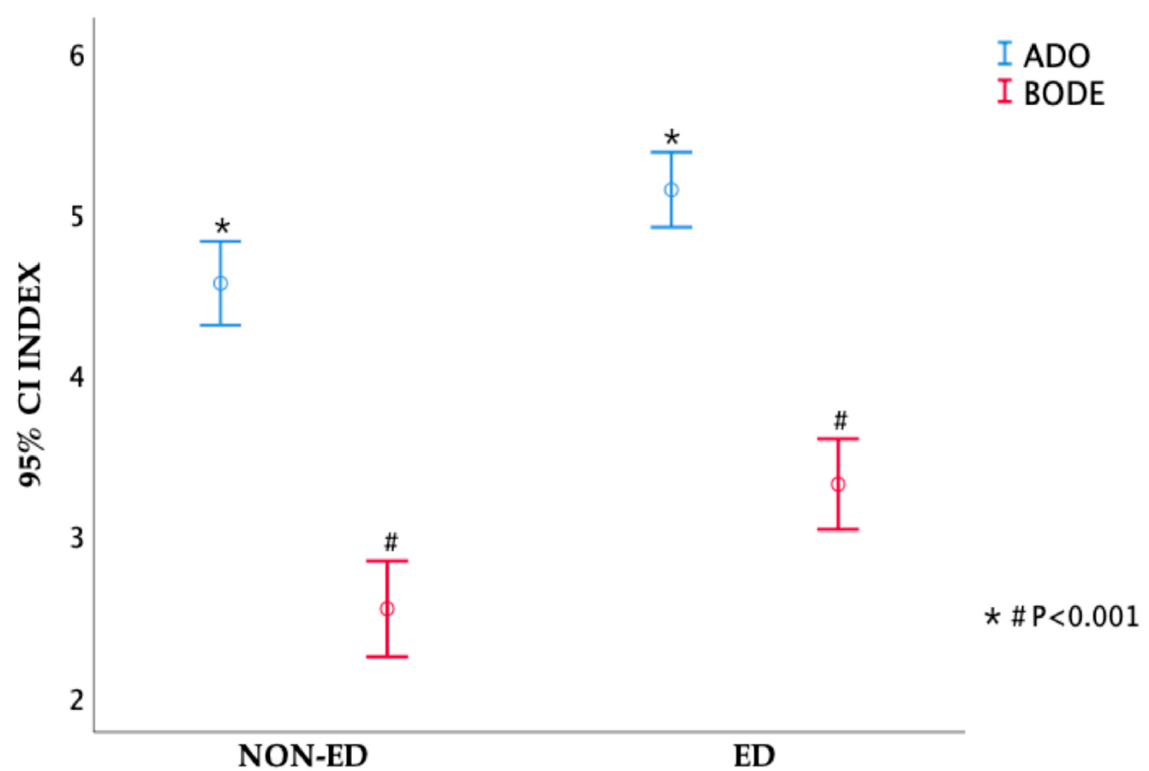
Figure 2. The difference of ADO index and BODE index between ED group and non-ED group.